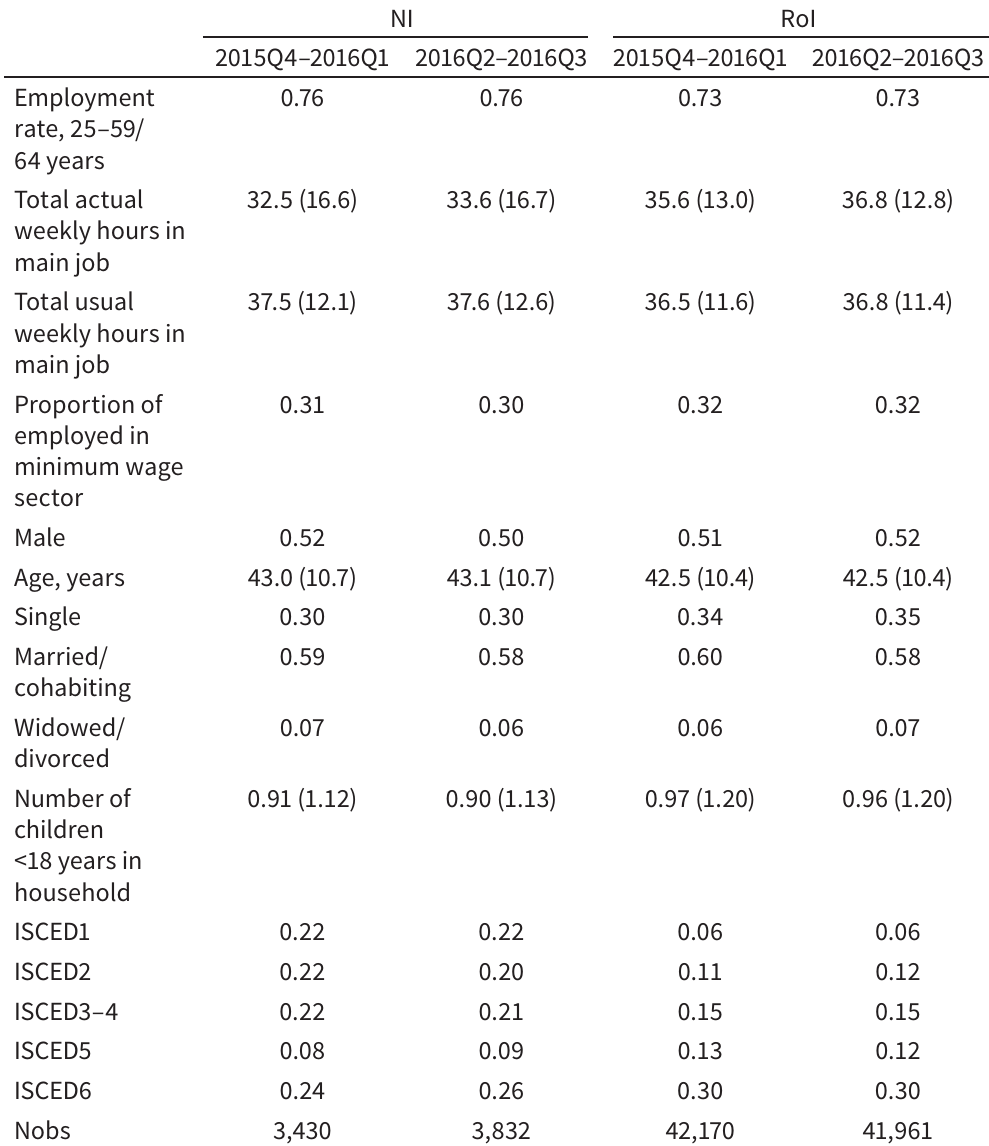
Sample means (standard deviations) for outcomes and other observable charac- teristics, NI and RoI, pre and post the introduction of NLW NI RoI